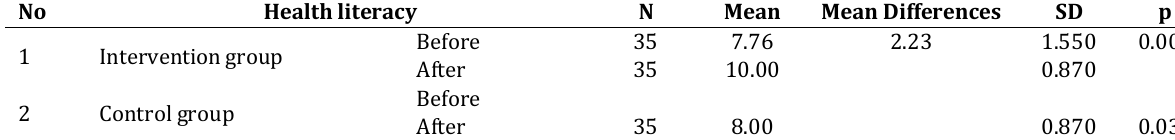
Table 2. The Difference of Health Literacy of the Respondents No Health